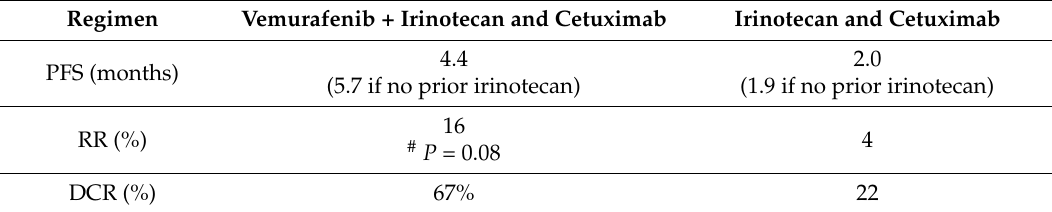
Table 12. Results of a clinical study to investigate the addition of vemurafenib to irinotecan